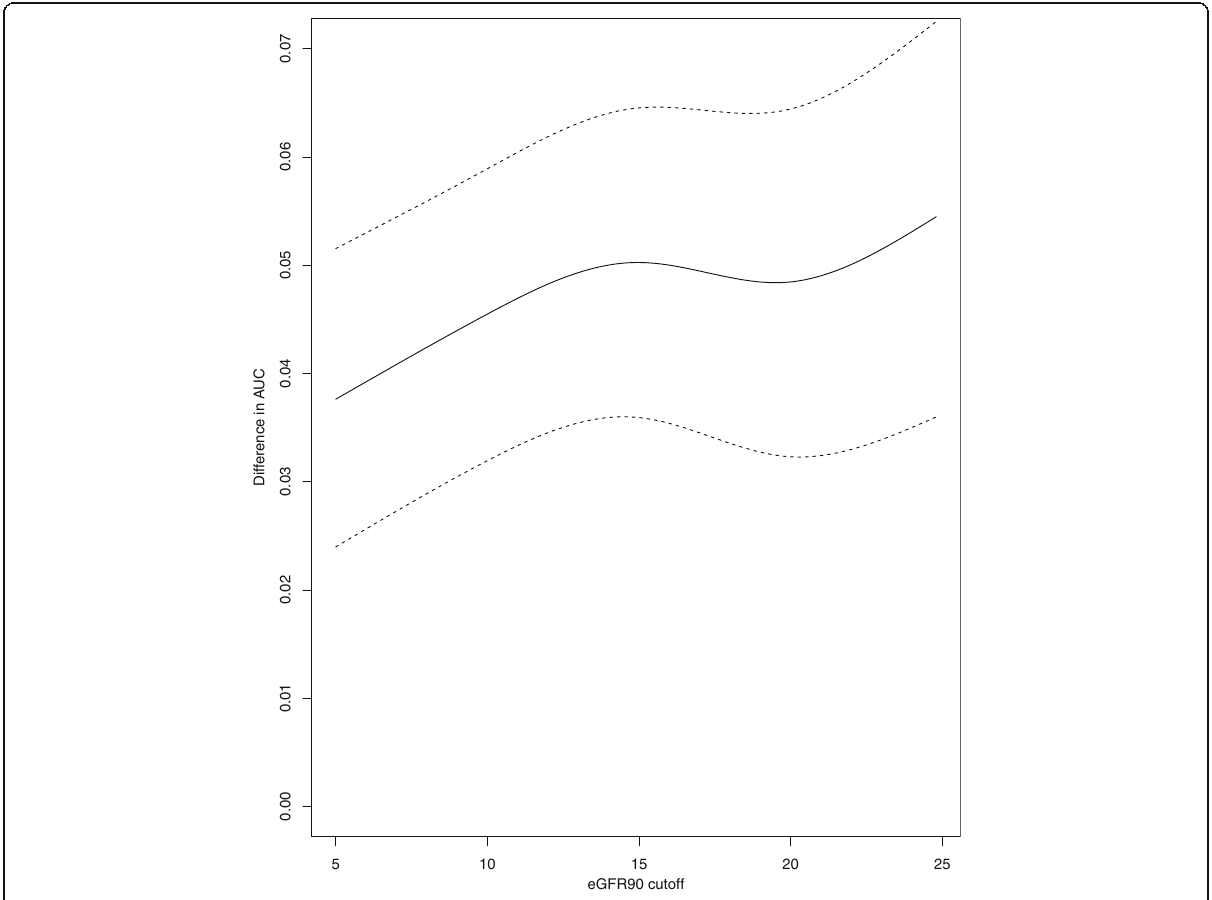
Fig. 3 Difference in the propensity score adjusted AUC over eGFR90 cutoffs ranging from 5 to 25 mL/min/1.73 m